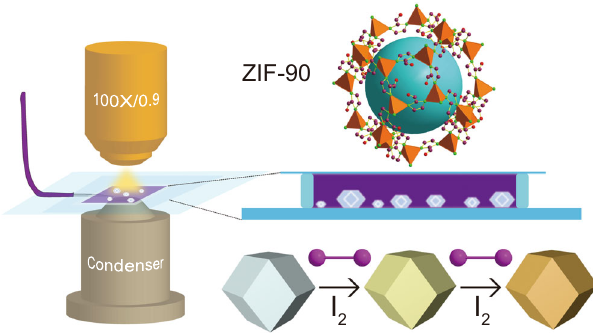
Fig. 1 Schematic illustration of visualizing gaseous I 2 adsorption on single ZIF-90 particles by dark- fi eld microscopy. DFM setup, the structure of ZIF-90, microchamber, and the color variation of ZIF-90 particle before and after adsorption of gaseous